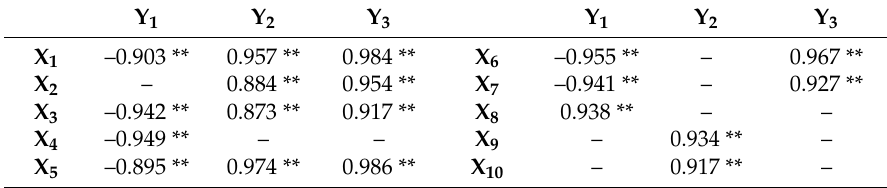
Table 6. The correlation coefficients between land-use changes and driving forces.